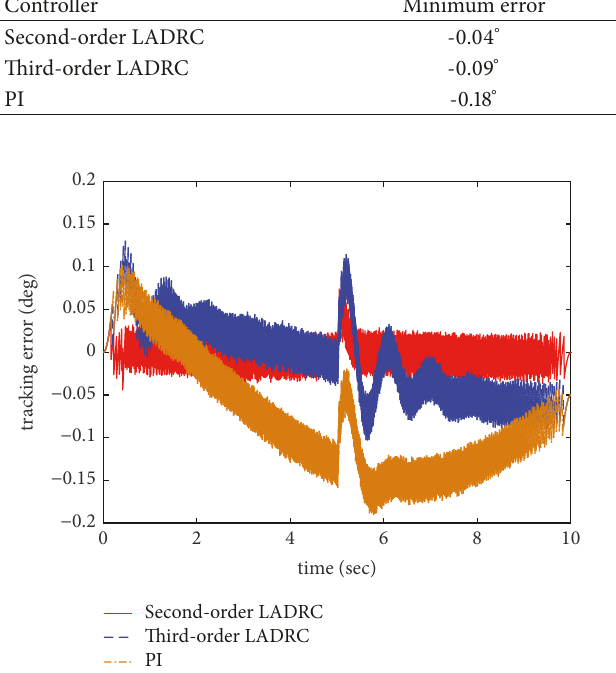
Figure 7: Tracking error curves with disturbance on control output.